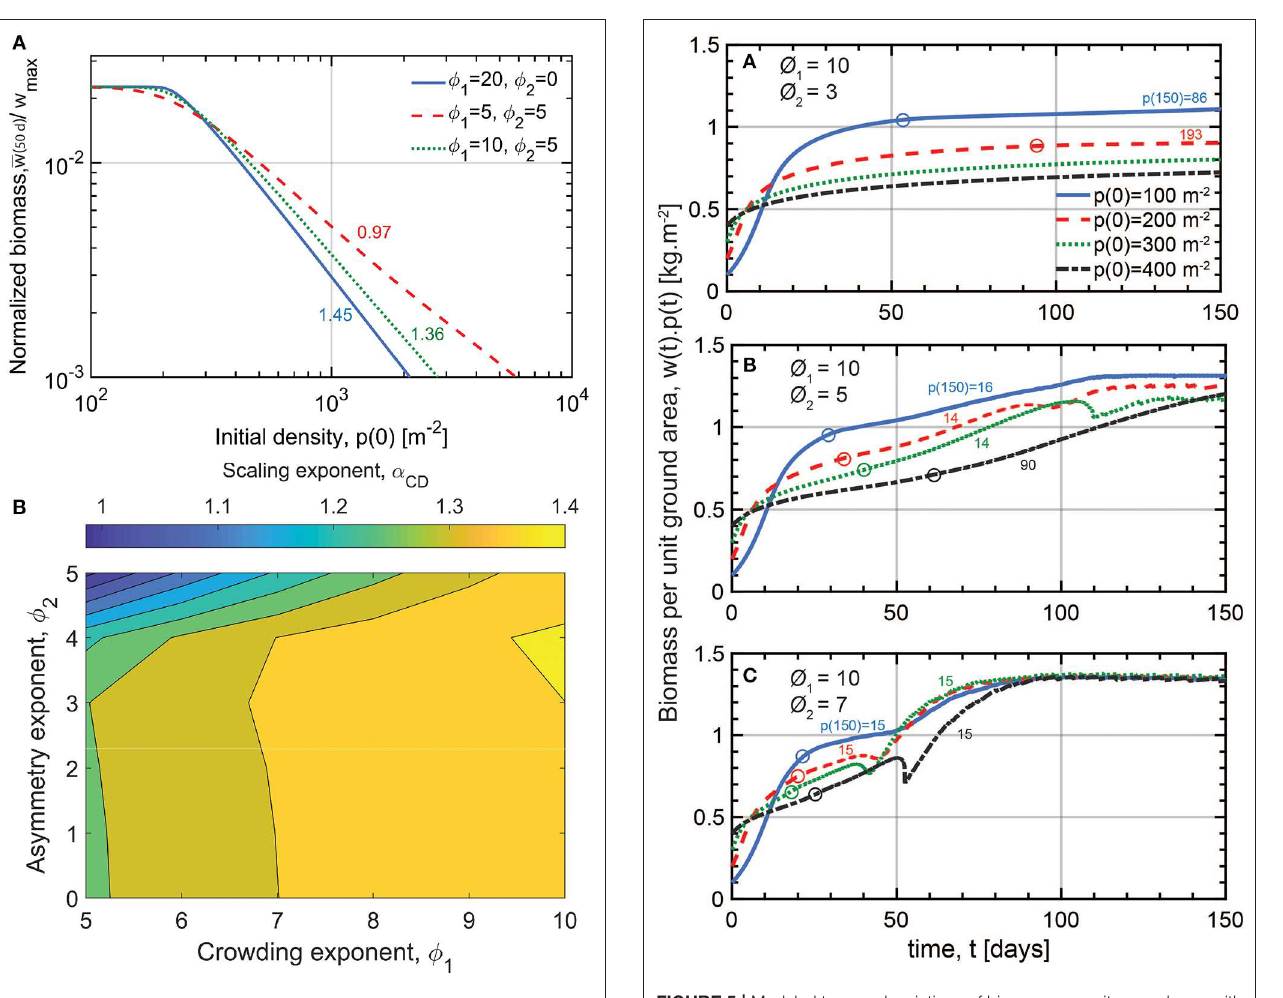
FIGURE 4 | (A) Each line represents modeled normalized biomass per individual for multiple simulations of different initial density p 0 after a fixed integration period of 50 days. The lines correspond to the three competition scenarios indicated in the legend. The corresponding scaling exponent α CD is displayed next to each plotted line. (B) Variation in α CD driven by different competition scenarios for crops (as determined by high initial plant densities and growth rates). Model parameters are found in Table S3 .